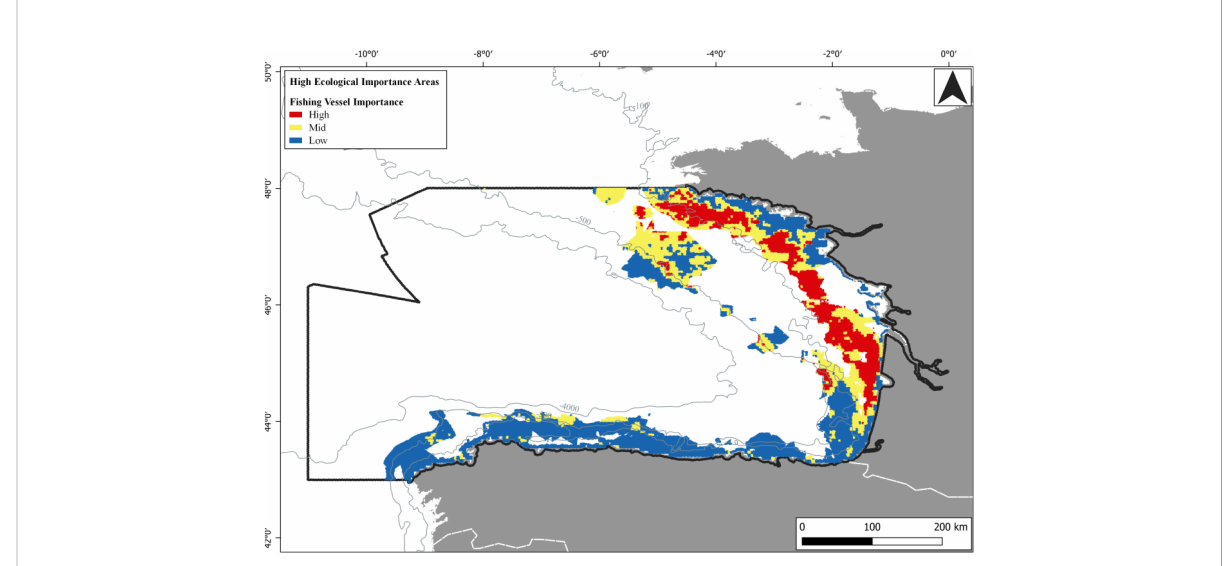
FIGURE 6 Fishing vessel density within high ecological importance areas in the Bay of